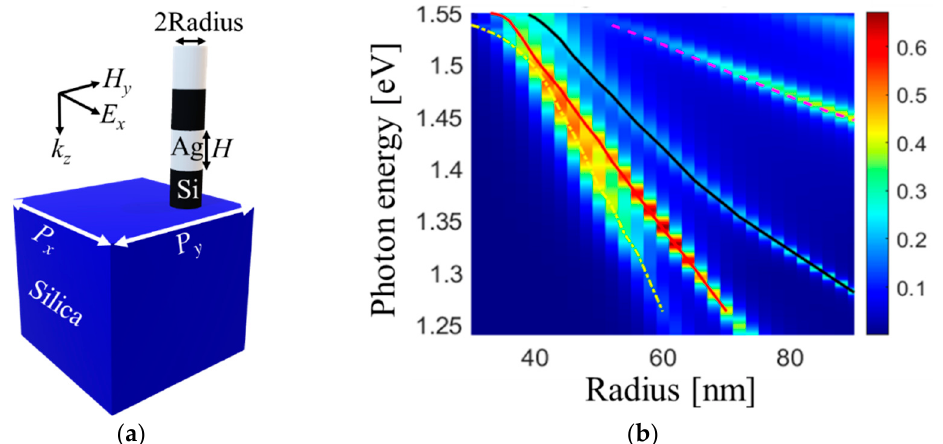
Figure 2. Nanostructure with one element. ( a ) Schematics of a single element in the unit cell. The element radius is R . Other geometrical parameters, materials, and illumination are the same as in the binary array. ( b ) Absorption for different radii. We perform calculations for a single element to aid in analyzing mode excitations in the binary array. Dot-dash yellow, solid red, and solid black lines are eyeball fit. They are subsequently transferred to Figure 1c,d to interpret the absorption mode maps.